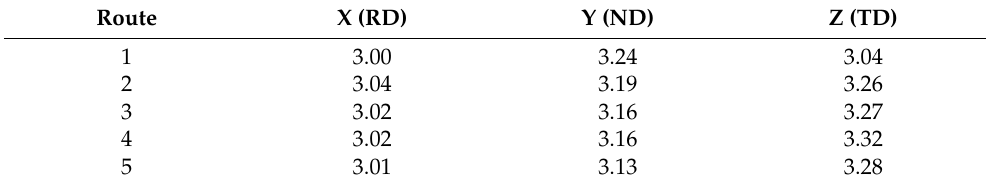
Figure 6. Taylor factors in TD for the central areas of the pipeline steel plates after TMCP.